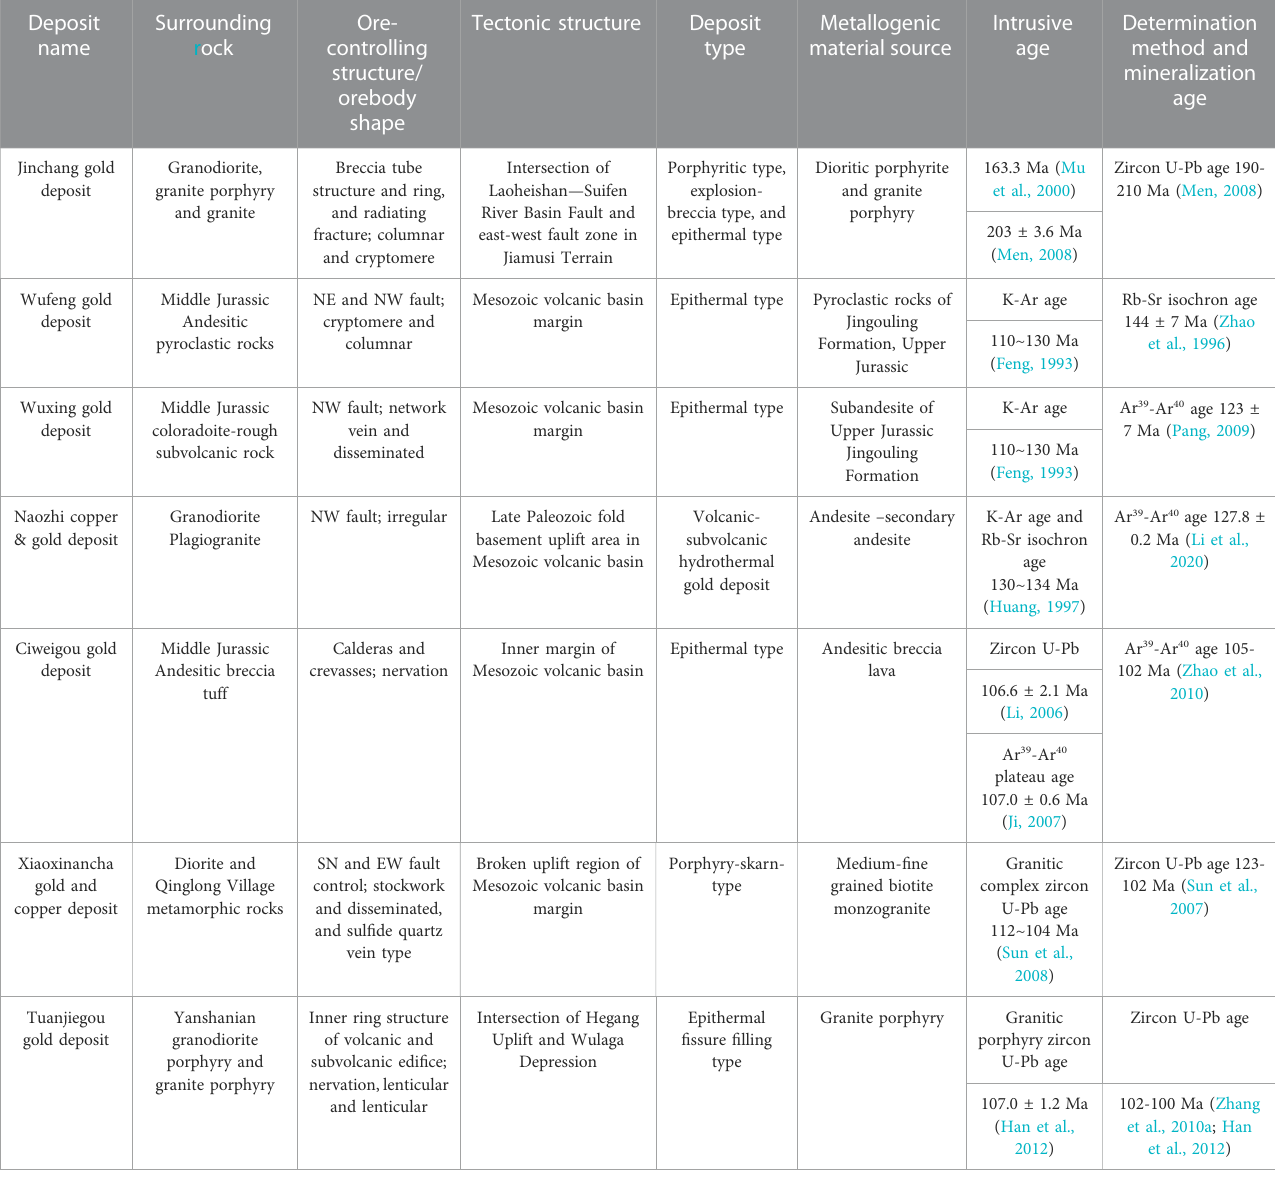
samples plot within volcanic arc granite region. In the Sr/Y-Y tectonic environment discrimination diagram, the intrusions in the study area are mainly located in the classic island arc granite region (Figure 13A).